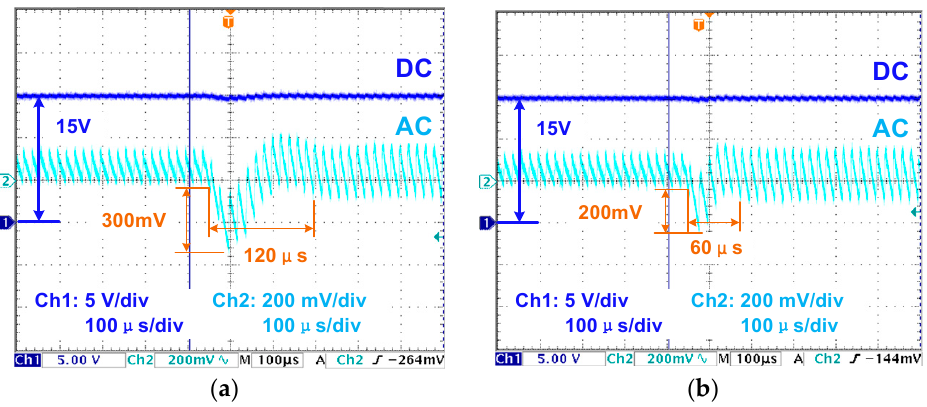
Figure 17. Output voltages when R steps from 50 Ω to25 Ω . ( a ) SCB controller, ( b ) OSCB